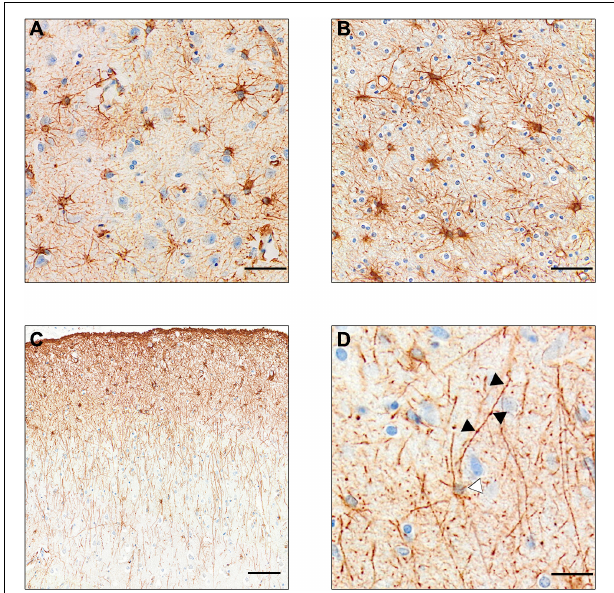
FIGURE 2 | GFAP+ stained astrocyte subtypes. (A) Protoplasmic astrocytes of the gray matter. Note the lighter staining, showing less expression of GFAP. (B) Darker stained fibrous astrocytes of the white matter. (C) Intralaminar astrocytes stretching process from layer I–II to layers III and IV. (D) Varicose projection astrocyte. Black arrows point to varicosities on the straight primary process. White arrow points to faintly stained cell body. [Scale bar (A,B) = 50 µ m, (C) = 100 µ m, (D) = 25 µ m].